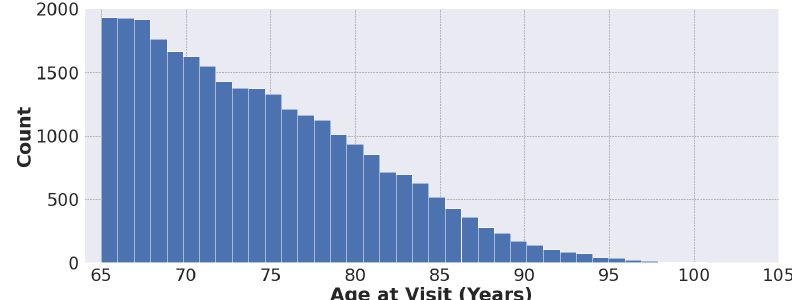
Figure 1. Distribution of patient age at visit (N = 28,728).